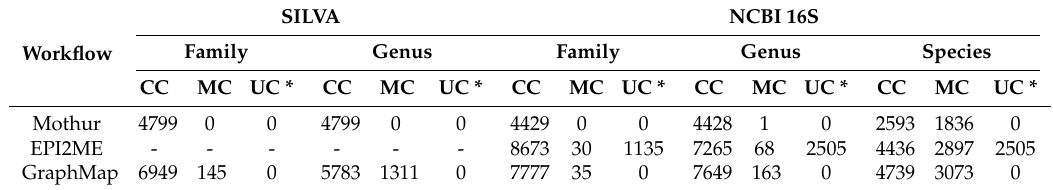
Figure 3. Correctly classified reads for all bioinformatics workflows at different taxonomic levels using the ( A ) SILVA and ( B ) NCBI 16S databases for ONT MinION data. Percentages are expressed against the total number of reads classified at any taxonomic level (SILVA only allows classification until the genus, and EPI2ME only supports the NCBI 16S database). Table 5. Classification results for MinION data for the different bioinformatics workflows and taxonomic levels using the SILVA and NCBI 16S databases. The total number of analyzed reads was 10,000 for all three bioinformatics workflows while the number of reads each bioinformatics workflow could identify at any taxonomic level is indicated. The values of correctly classified, misclassified, and unclassified reads at a given level sum to the total number of classified reads at any